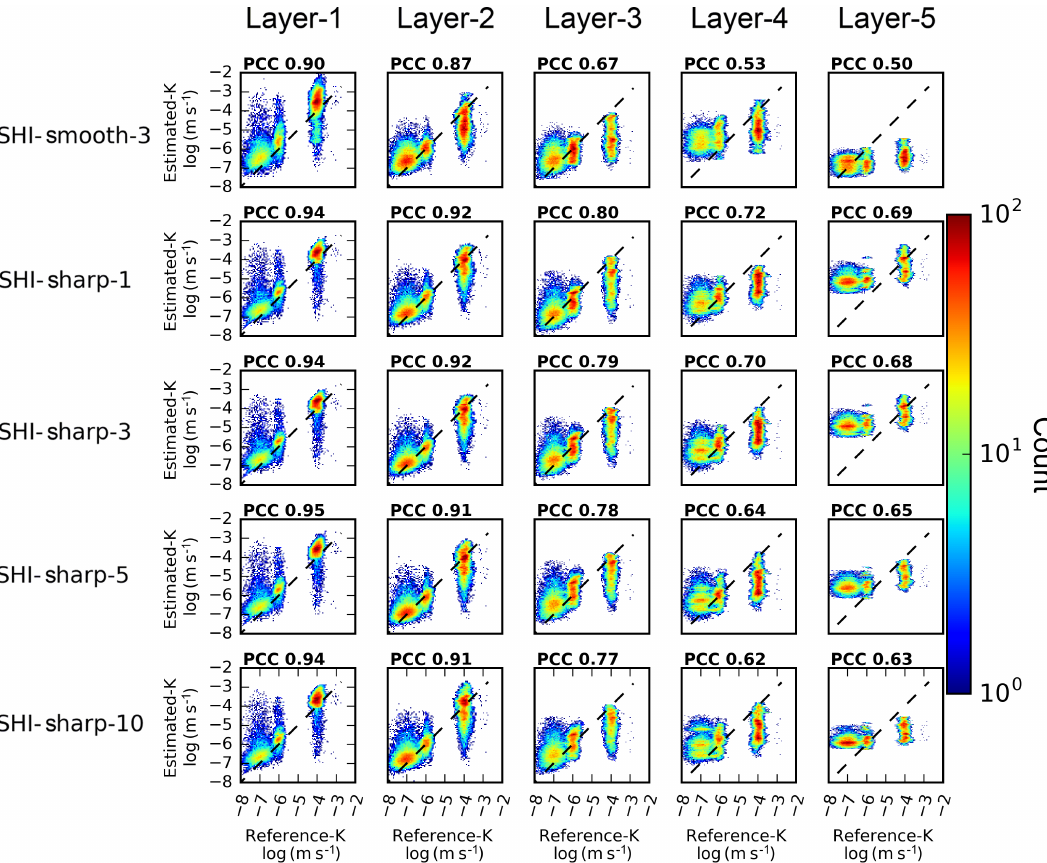
Figure 8. Scatter plot of true and estimated hydraulic conductivity fields for smooth geophysical inversion and sharp geophysical inversion for different data qualities of the AEM data for model realization number 20. On top of each window the Pearson correlation coefficient (PCC) is calculated.